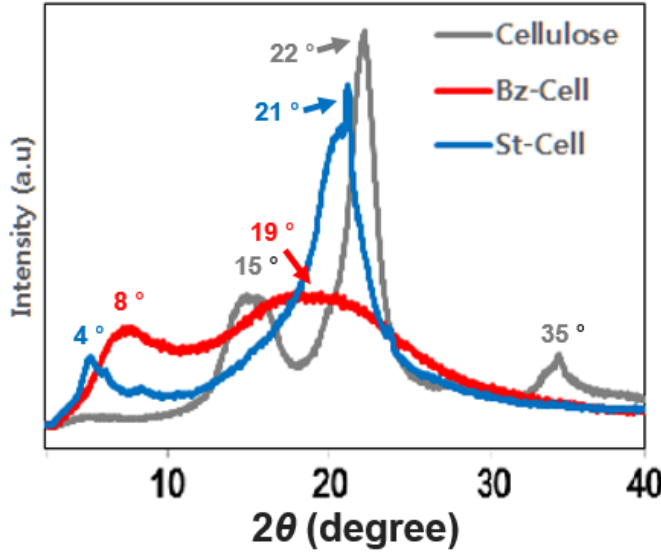
Figure 5. X-ray diffraction analysis (XRD) analysis of Cellulose (gray); Bz-Cell (red); and St-Cell (blue).